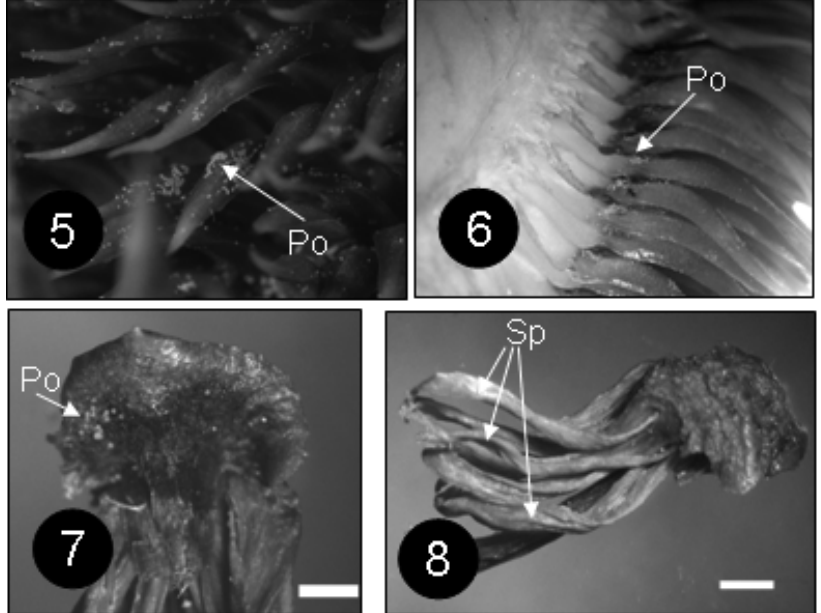
Fig. 5 – Pollen (Po) adhered to megasporophils of an immature female cone. Fig. 6 – Detail of the internal portion of the female cone with pollen grains adhered. Fig. 7 – Detail of the posterior portion of the microsporophil with pollen grains adhered. Scale bar = 0.1 cm. Fig. 8 – Microsporophils with eight sporangia (Sp) in adaxial view. Scale bar = 0.1